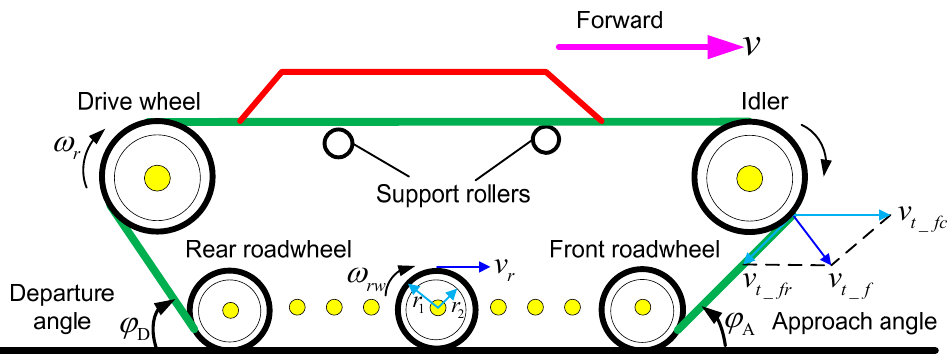
Figure 2. Schematic diagram of forces acting on track and wheels.